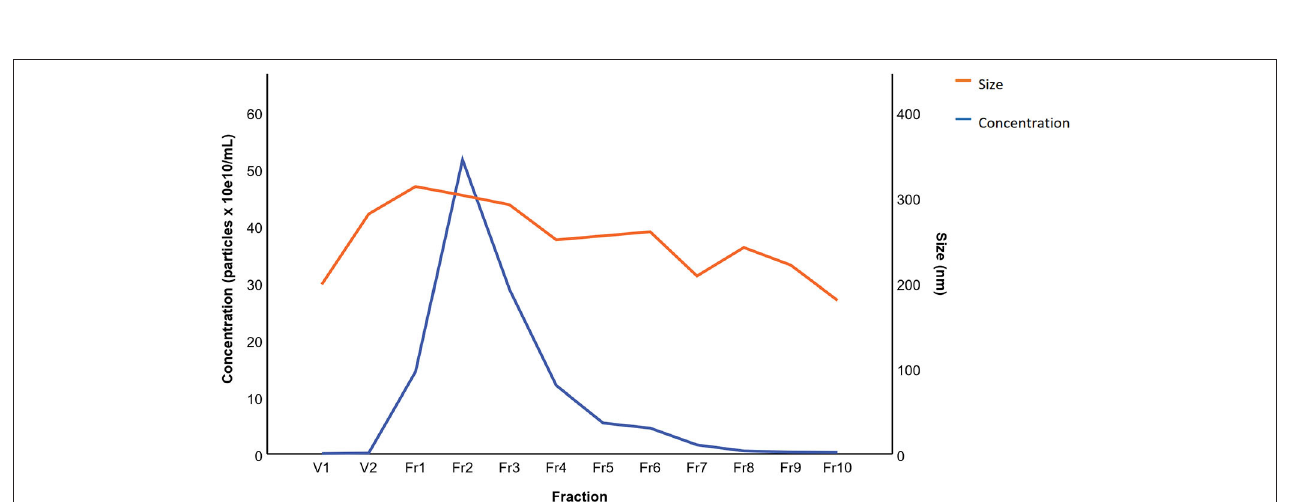
FIGURE 2 | Mean particle concentration and size in extracellular vesicle sample fractions from five horses isolated by size-exclusion chromatography. The fractions were analyzed by nanoparticle tracking analysis.